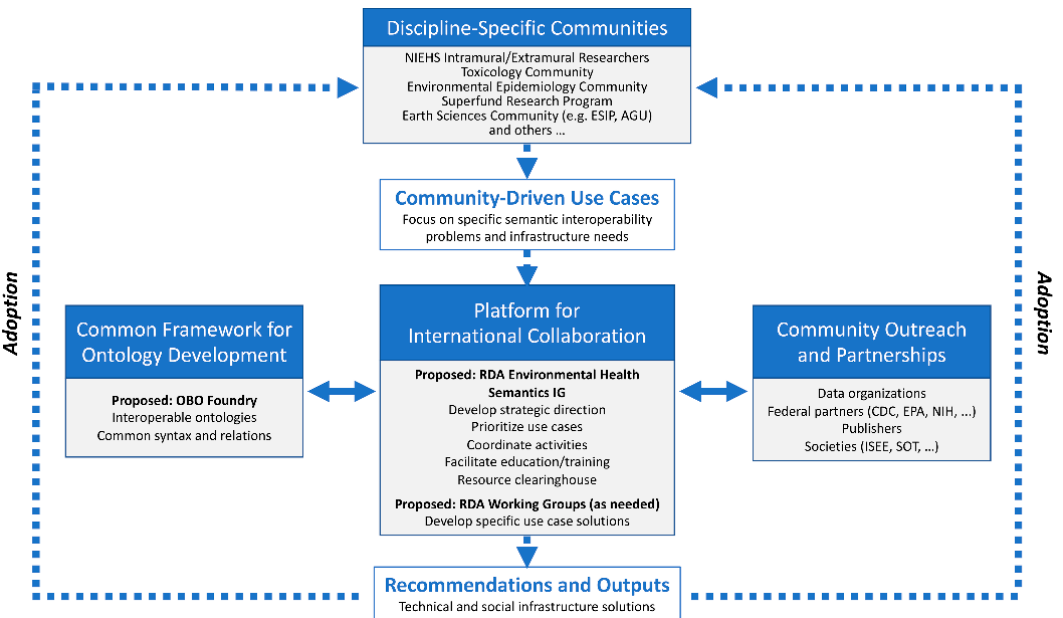
Figure 6. Draft community model for the organization of the Collaborative.